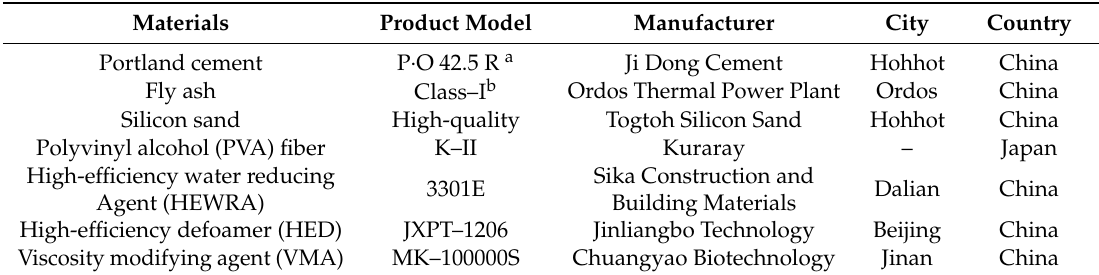
Table 1. Source information of materials (Product Model, Manufacturer, City,